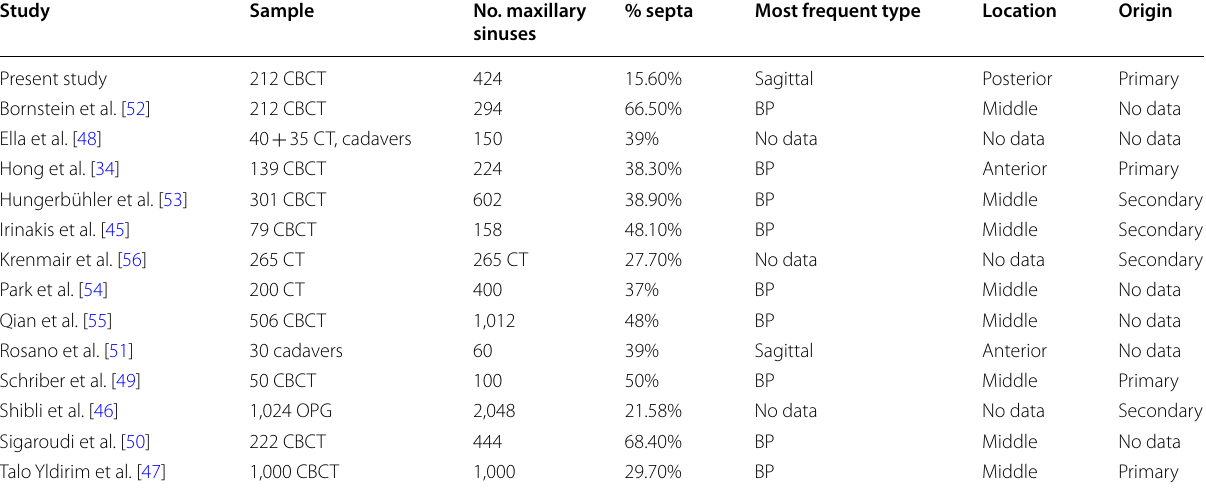
Table 5 Review of MSS data from other studies